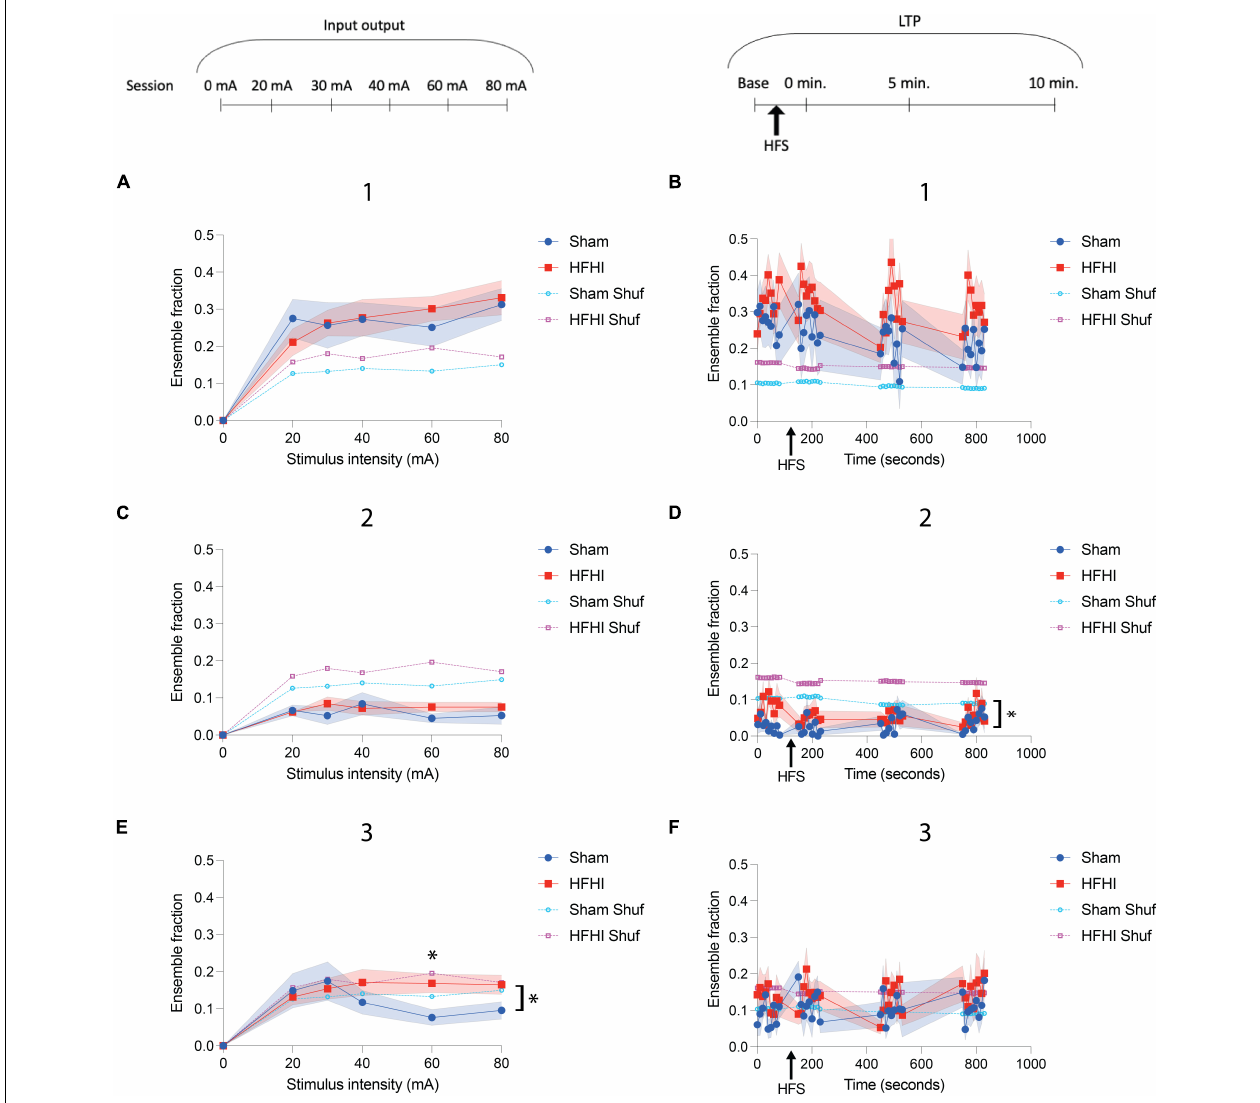
FIGURE 5 | High Frequency Head Impact (HFHI) increases ensemble size during coordinated activity periods. (A) HFHI and sham slices display increasing number of events during the first ensemble maximum with increasing stimulus intensity, but no differences were observed between the group. (B) Potentiation of the CA1 field with HFS did not alter transient frequency during the first ensemble maximum. (C) Calcium transient frequency during the ensemble minimum remained low for both groups throughout the input/output paradigm relative to the ensemble maxima and did not differ with stimulus intensity. (D) A significant difference in the fraction of ensemble with calcium transients during the ensemble minima between the groups was seen (E) Sham ensemble activity during the second ensemble maxima appeared to be inversely related with stimulus intensity while HFHI slices remained stable at higher stimulus intensities, leading to a significant interaction between time and group. (F) The activity during the second ensemble maximum was not altered by HFS and did not differ between groups. Shaded regions represent mean ± SEM. With brackets: mixed effects analysis, * p < 0.05, comparing real data (non-shuffled) from each group. Above graph in E) Šídák’s multiple comparisons test, * p = 0.05 n Sham = 13, n HFHI =